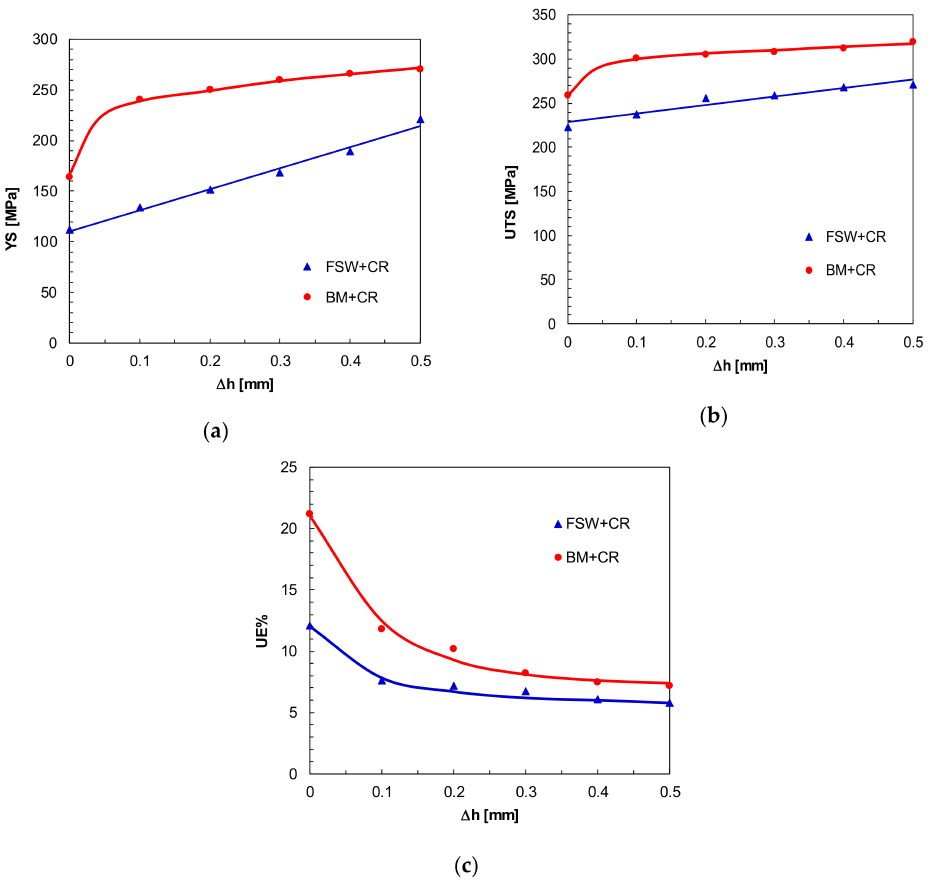
Figure 3. Comparison between the mechanical behaviour exhibited by the FSWed+CRed and BM+CRed samples in terms of: ( a ) Yield strength vs. height reduction; ( b ) Ultimate tensile strength vs. height reduction; ( c ) Ultimate elongation vs. height